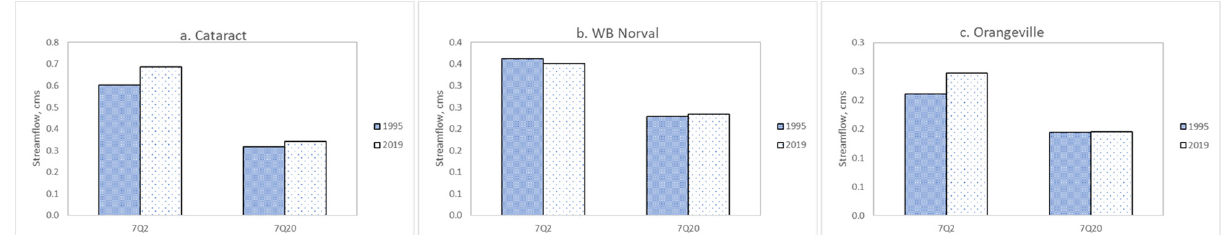
Figure 10. Comparison of the low flows for the return periods 7Q 2 and 7Q 20 from 1995 to 2019 for two rural gauges ( c ) Orangeville and ( a ) Cataract and one urban gauge ( b ) WB Norval. The graph shows an increase in the return level in 2019.